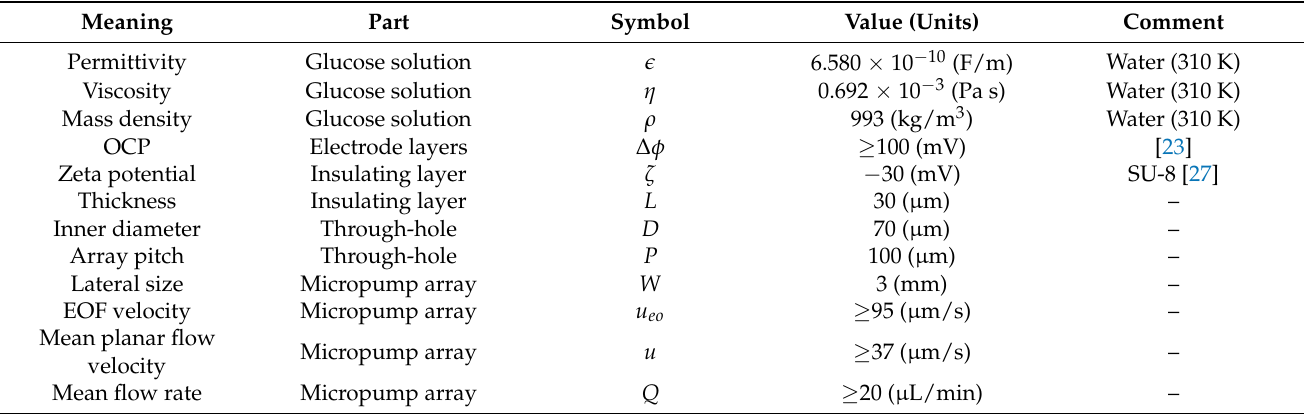
Table 1. Design parameters and estimated